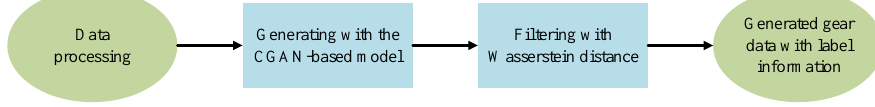
Figure 3. The flow-process diagram of our proposed